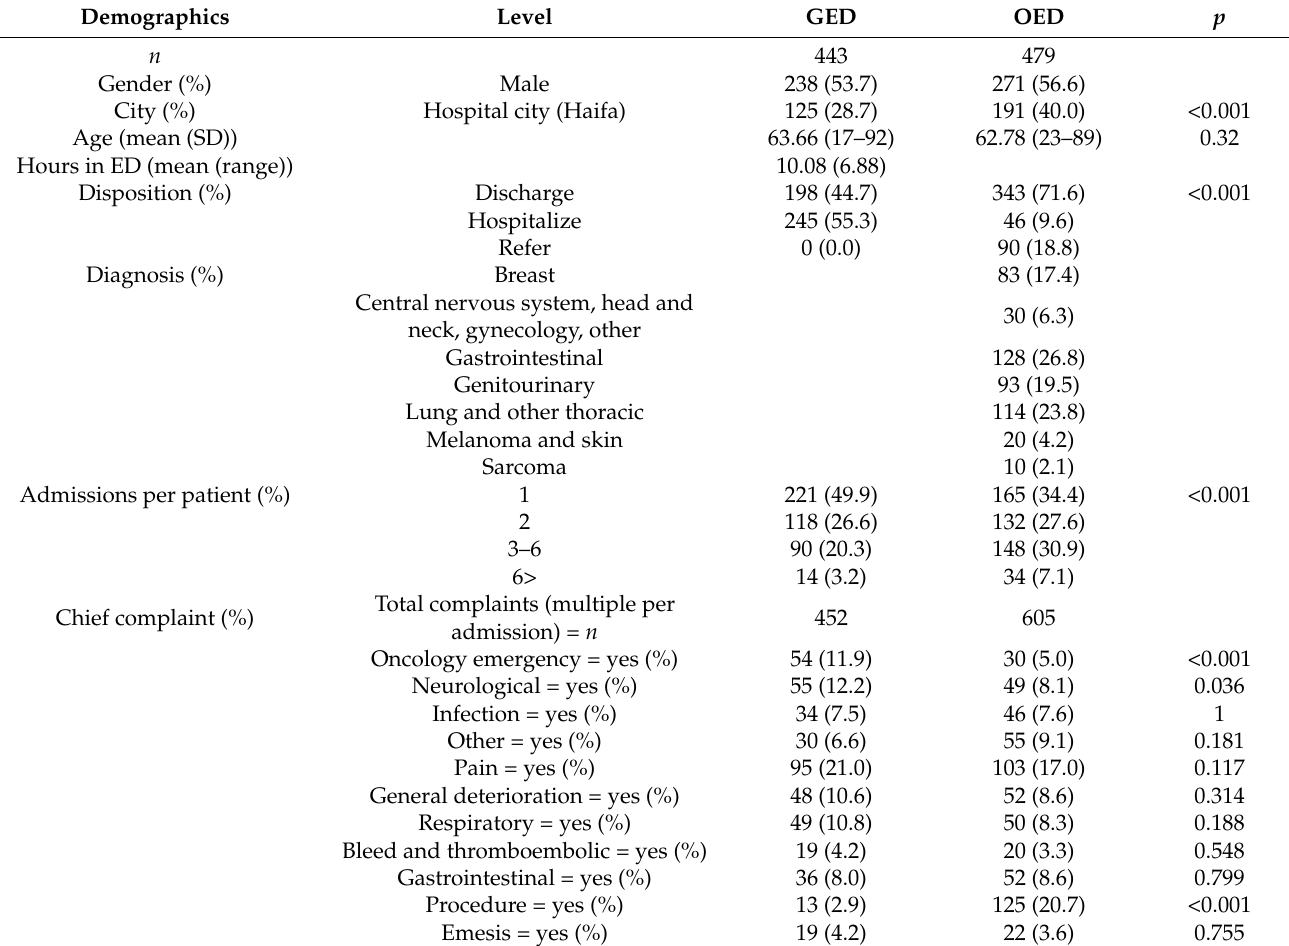
Table 1. General demographics of the patients visiting the emergency settings from April to June